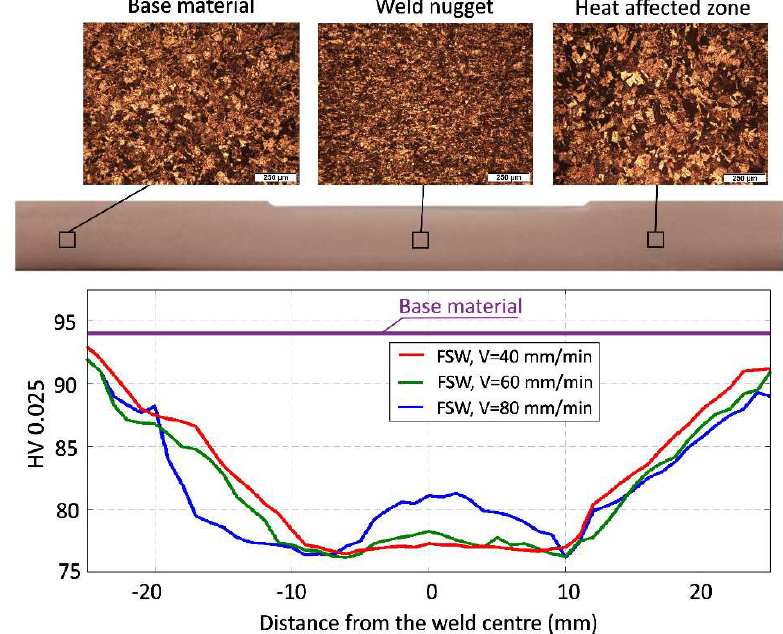
Figure 6. Microhardness profiles of the FSW joints corresponding to various traverse speeds and comparison of representative microstructure images in selected zones of the FSW copper joints produced with a traverse speed of 80 mm/min.